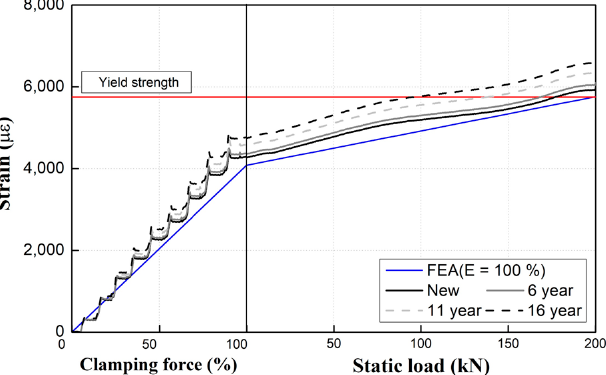
Figure 15. Comparison of experimental and analytical results for used products (E-100%).